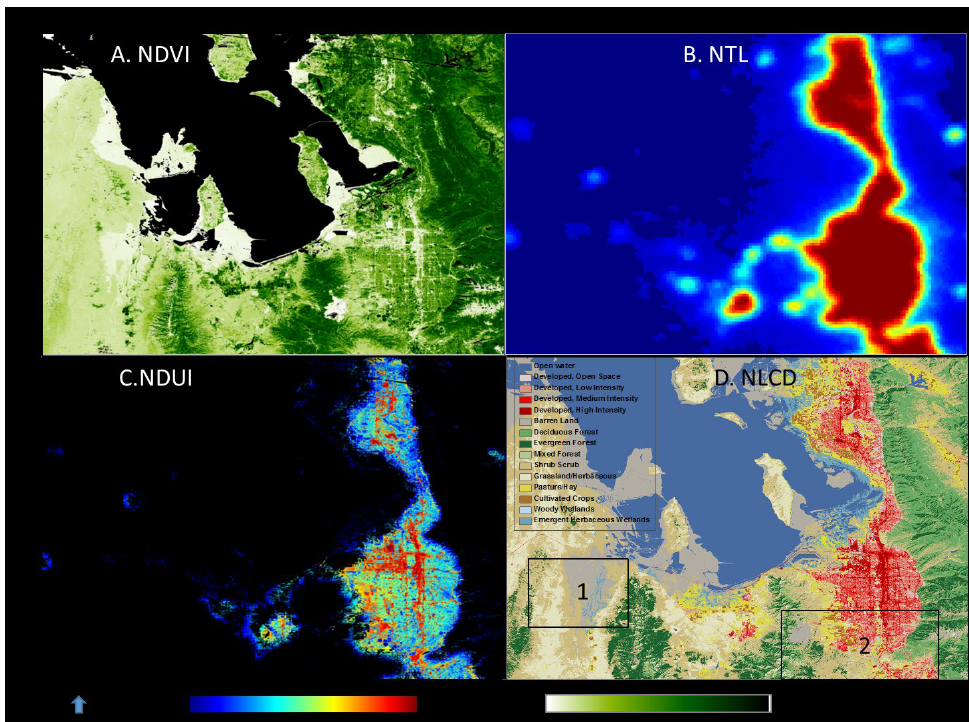
Figure 9. The 2006 NDVI ( A ), NTL ( B ), NDUI ( C ), and NLCD ( D ) maps in the Salt Lake City area, Utah.